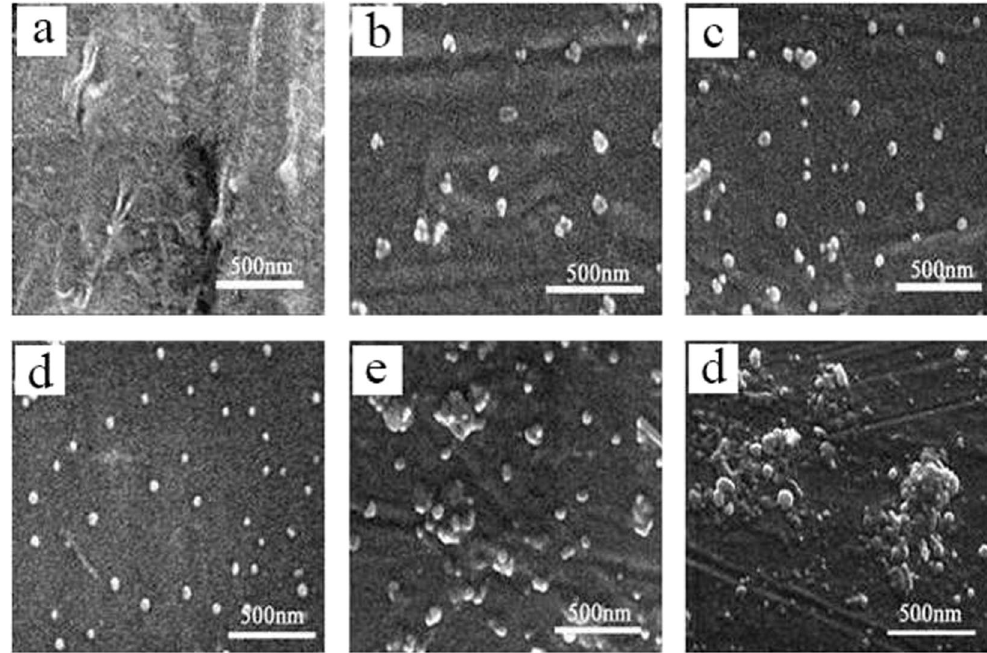
Figure 2. SEM micrographs of cryogenically fractured melt-processed PPS/C60 with different weight fractions of C